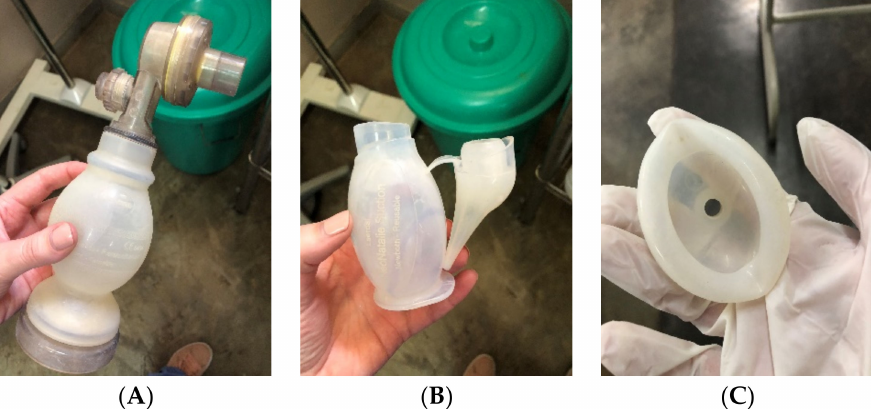
Figure 6. Reprocessed equipment in a referral hospital in Malawi. ( A ) Disinfected bag-mask device, ( B ) disinfected suction bulb, and ( C ) disinfected, warped mask. Images A. White,